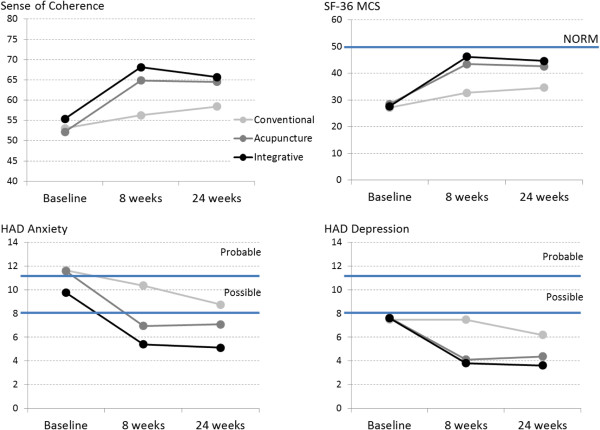
HAD anxiety, HAD depression, SF-36 MCS and Sense of Coherence mean scores at baseline, and at 8 and 24-week follow up for the three treatment groups. Solid horizontal lines indicate HAD cutoffs for possible (scores 8- < 11) and probable (≥11) and the SF-36 MCS norm value (50) for the general Swedish population.